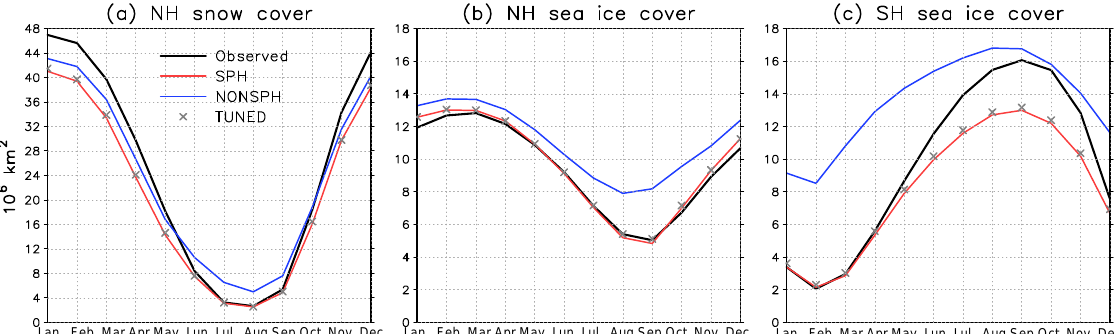
Figure 9. (a) Seasonal cycle of Northern Hemisphere land snow cover in the NOAA snow cover extent CDR (Robinson et al., 2012; Estilow et al., 2015; black curve) and in the SPH (red curve), NONSPH (blue curve), and TUNED (crosses) experiments. (b) Northern Hemisphere and (c) Southern Hemisphere sea ice cover in the NSIDC passive microwave sea ice concentration CDR (Meier et al., 2013; Peng et al., 2013) and in the NorESM experiments. For both snow cover and sea ice, the observations are averaged over the years 1990–2014. To account for missing sea ice data in the NSIDC product around the North Pole, 0 . 33 × 10 6 km 2 has been added to the observed values in (b)